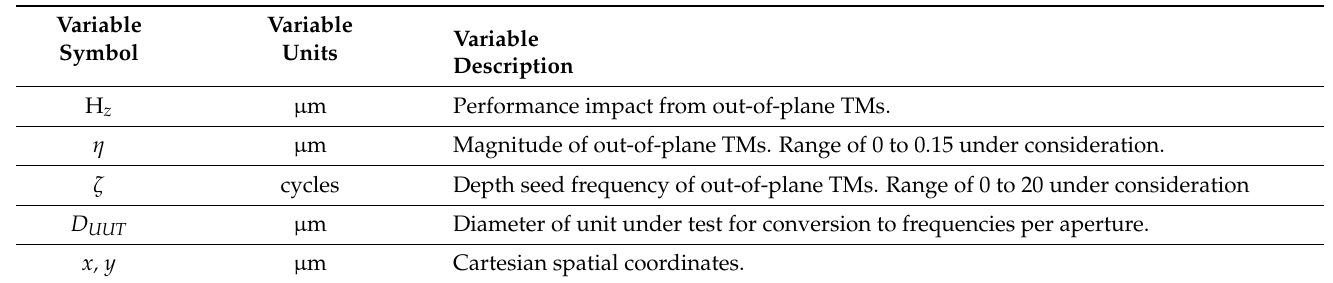
Table 3. In-Plane TM Variable Definitions.